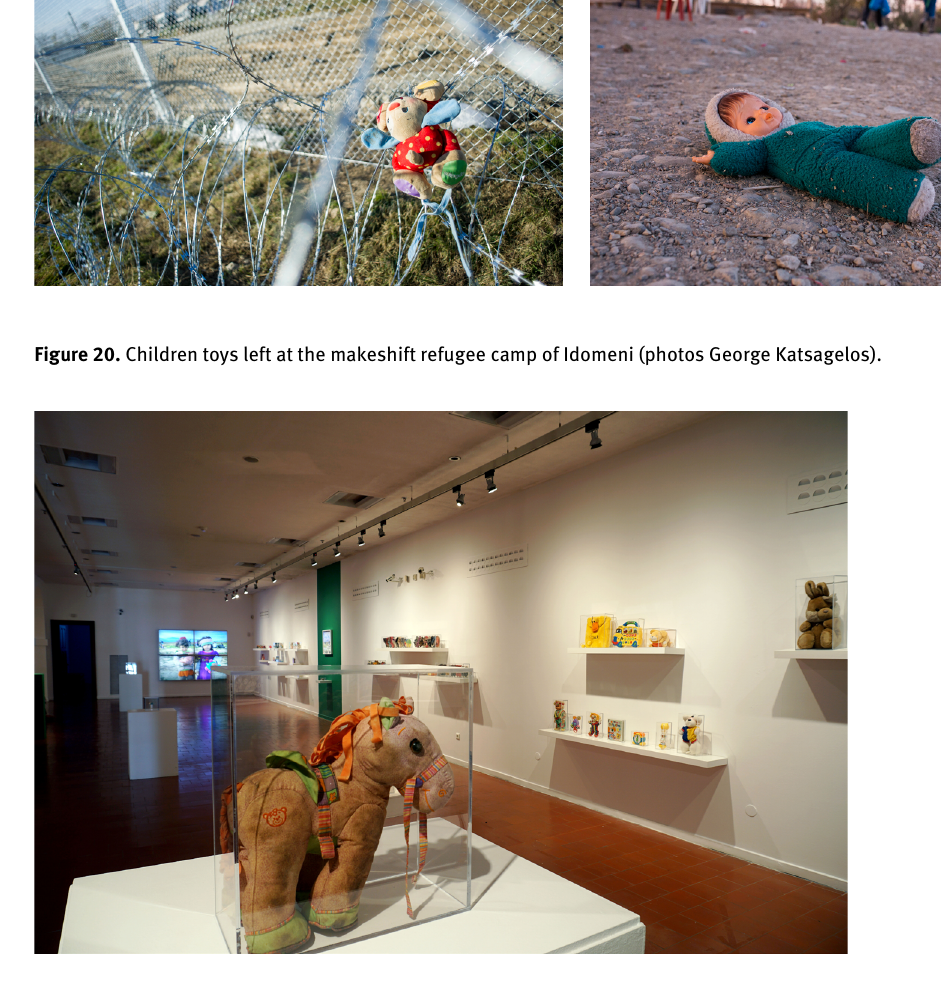
Figure 21. “Relics to Eternity in Idomeni 2015–2016”, A multimedia installation by George Katsagelos held at the Greek